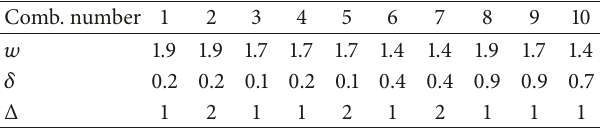
Table 4: Ten best parameter combinations for RMNL-Markov model. Comb. number 1